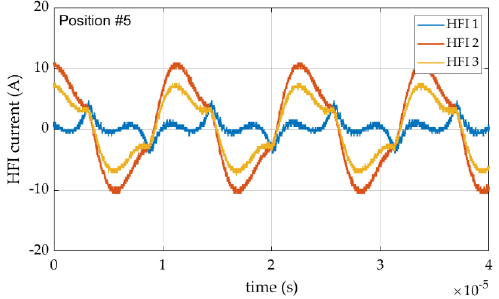
Figure 21. HFIs output currents with partial coupling with the second and the third track coils (Position #5).